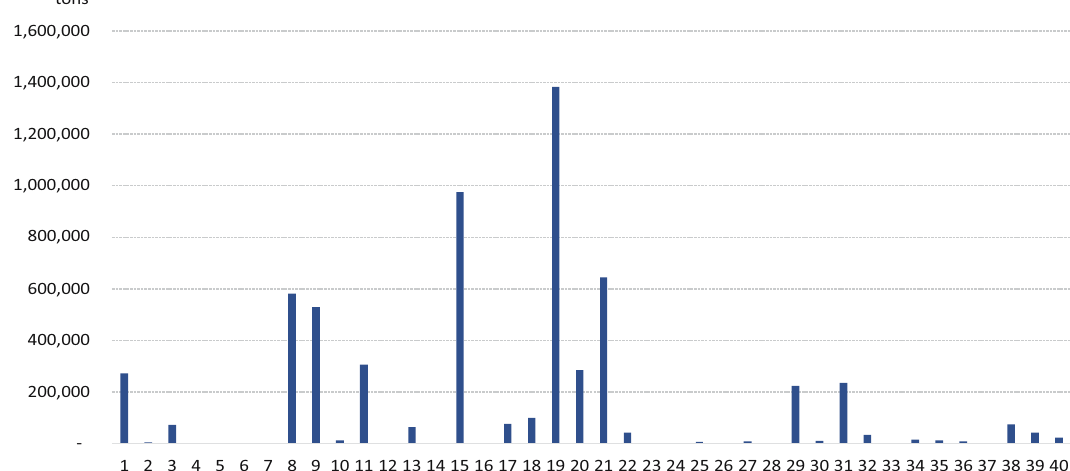
Regardinginvestigateddataonproductionprocesses/norms, distribution, consumption, and recycling, the research surveyed 10 plastic factories, and 45 household - scale facilities in plastic recycling trade villages. Among the factories, there are fi ve facilities producing plastics for intermediate demand ( such as plastic fi lm and planks ) and fi ve facilities producing plastic resins. Among the households, 30 facil - ities are producing plastics for intermediate demand and 15 facilities are producing plastics for fi nal demand. All these factories and households are located in the North of Vietnam. Regarding experimental data on disposable plas - tics, the research sampled solid waste at Nam Son land fi ll, the biggest land fi ll in the North. The sampling and compo - nent analyzing method were followed six standard steps [ 25 ] .